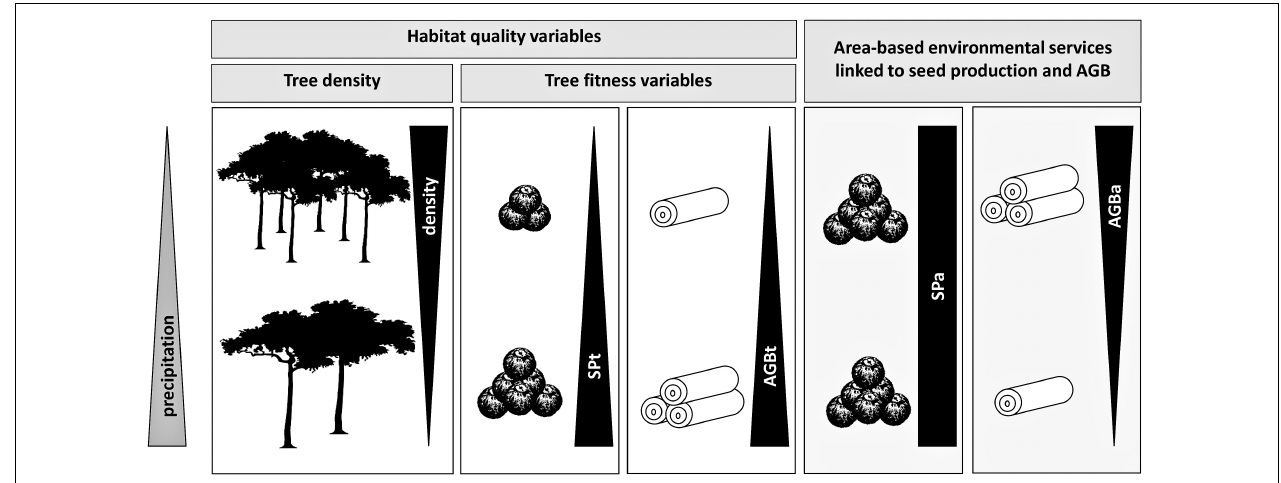
FIGURE 7 | Graphical illustration of how different habitat quality variables and area-based ecosystem services, linked to seed production and AGB of Brazil nut, respond to a precipitation gradient. The positive and negative correlations with precipitation of SP t and tree density, respectively, neutralize one another, resulting in invariable SP a regardless of precipitation levels. By contrast, the negative correlation of tree density with precipitation dominates the positive one of AGB t , resulting in a negative correlation of AGB a